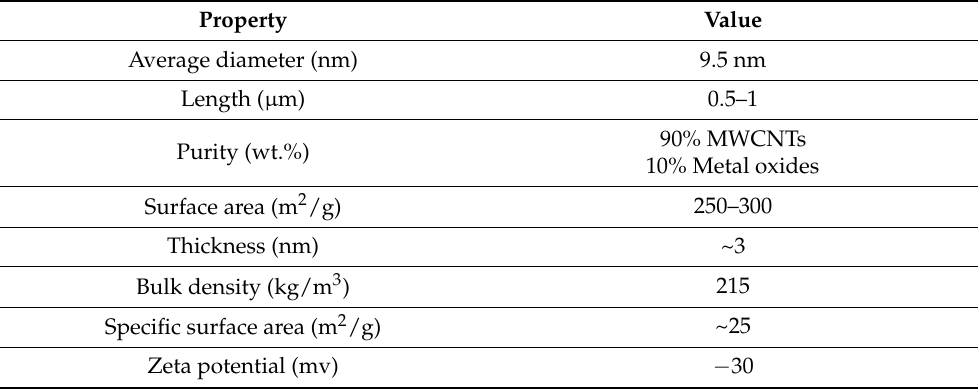
Table 1. Physical and chemical properties of multiwalled carbon nanotubes